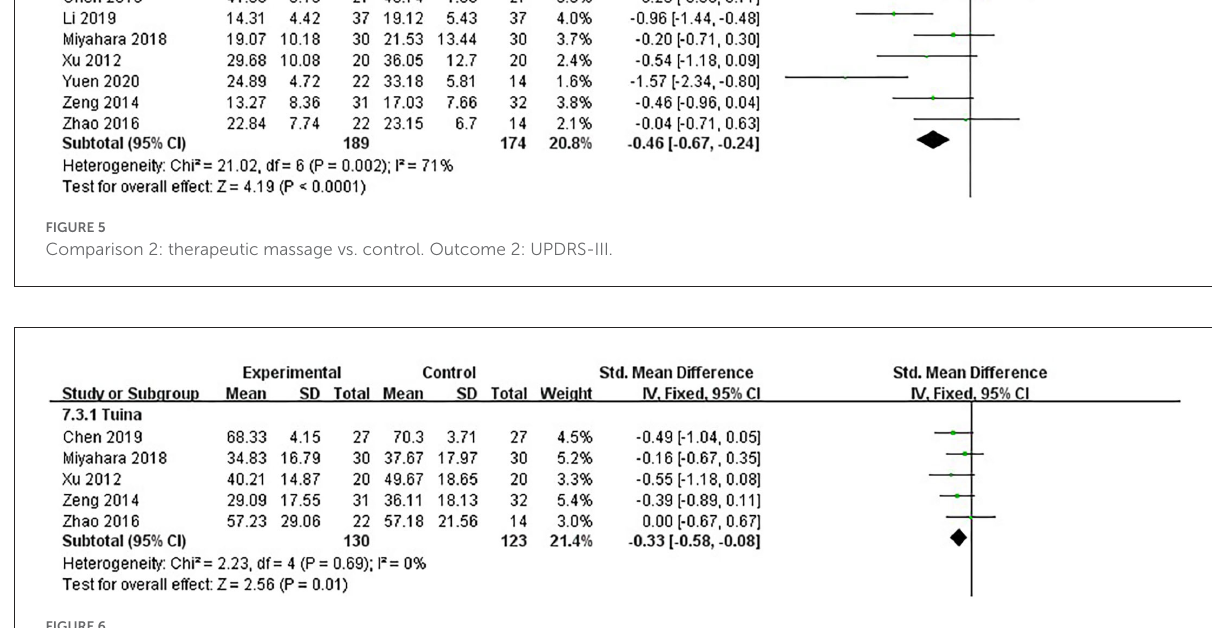
[SMD = − 0.33, 95% CI ( − 0.58, − 0.08), p < 0.05] (Figure